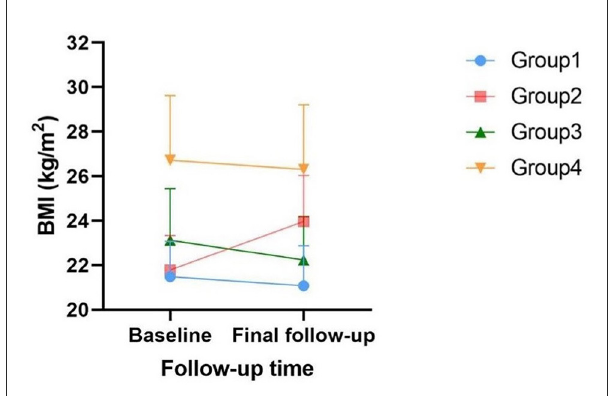
FIGURE2 Visualization of four groups defined by BMI